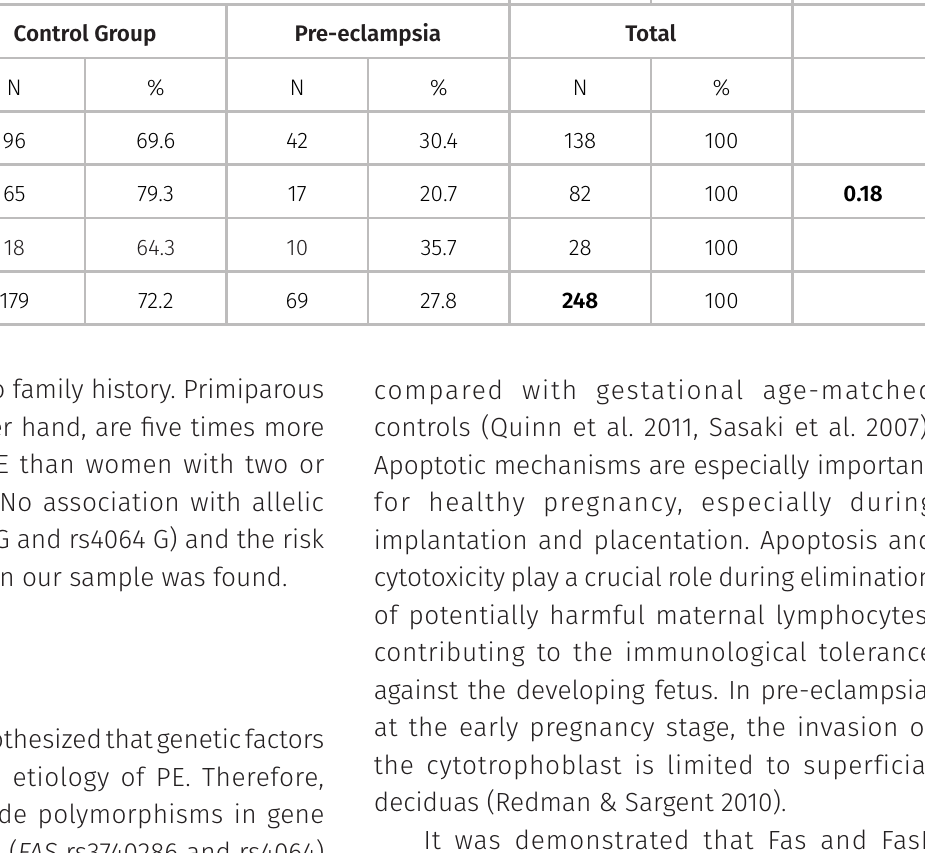
Table I. FAS (rs3740286) genotypes found in women with and without pre-eclampsia.